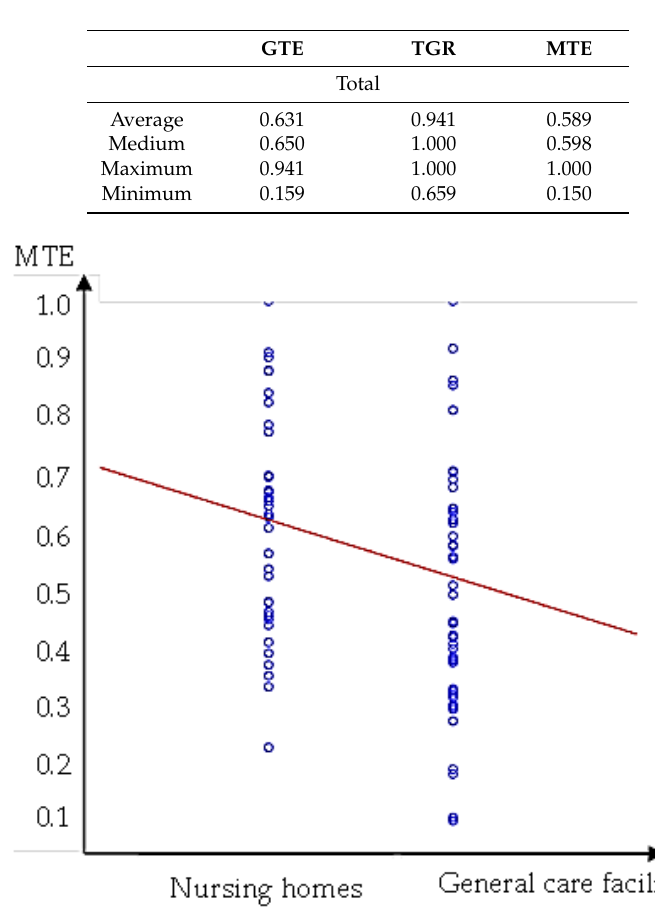
Figure 4. Metafrontier efficiency (MTE) results of different types of senior facilities. Table 9. Percentage of benchmark facilities in each sample.